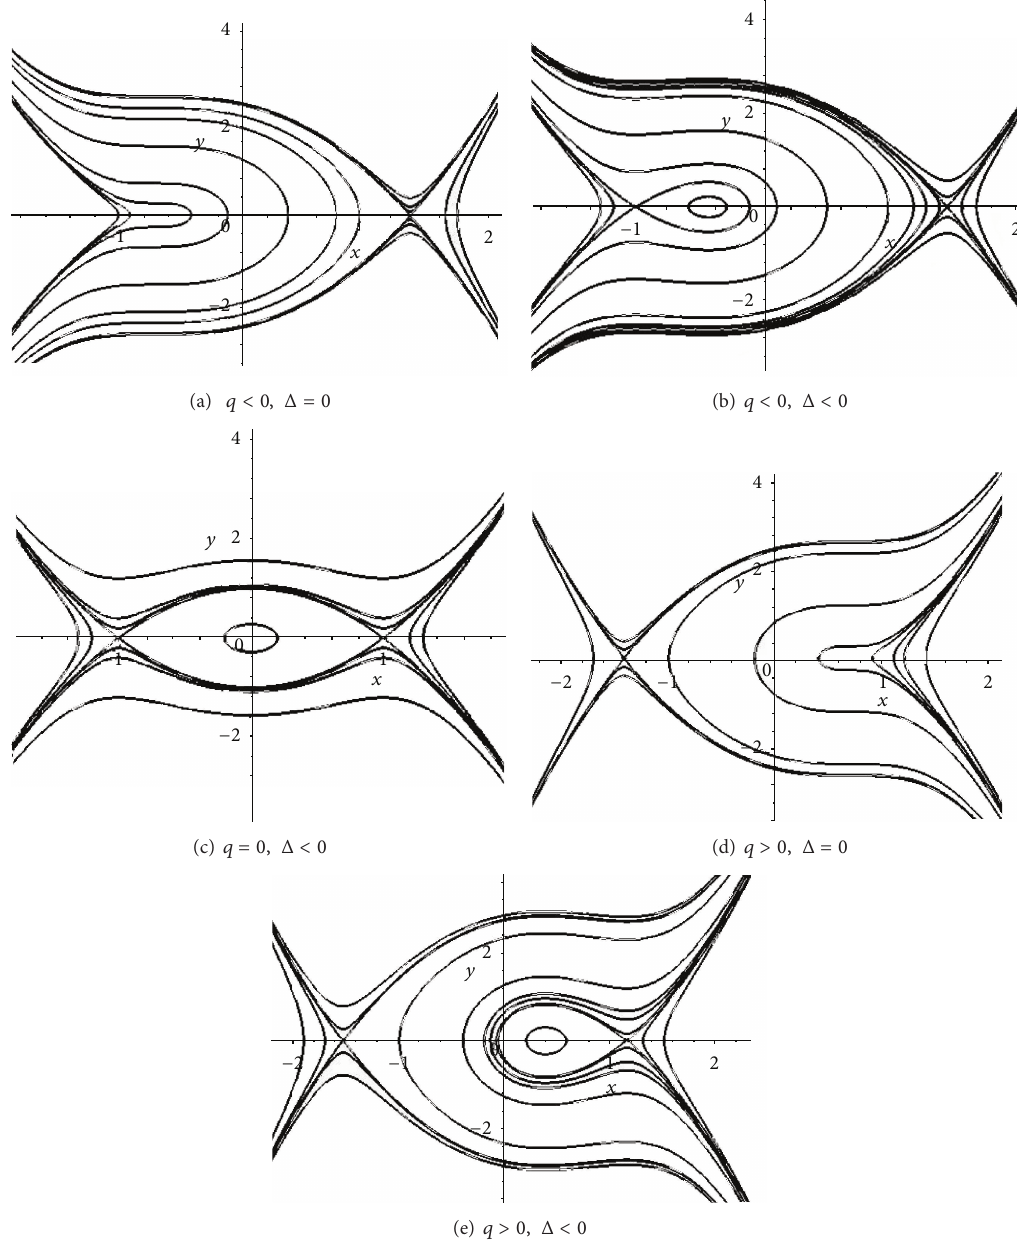
Figure 1: The phase portraits of system (9) for 𝑏 3 > 0